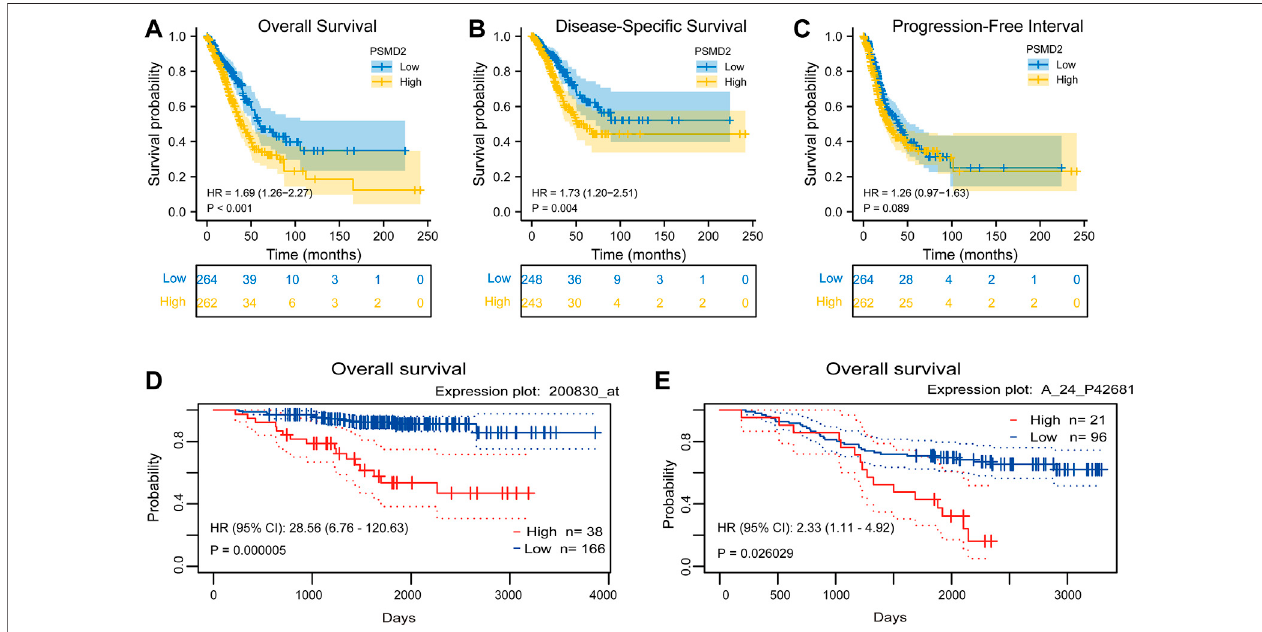
FIGURE 3 | Correlation between PSMD2 expression and prognosis in lung adenocarcinoma. (A) Higher PSMD2 expression had a shorter overall survival. (B) Higher PSMD2 expressionhadashorterdisease-speci fi csurvival. (C) Nosigni fi cantdifferencewasobservedbetween PSMD2 expressionandprogression-freeinterval. (D,E) Two datasets (GSE31210, GSE13213) in PrognoScan suggested that high PSMD2 expression was correlated with poor overall survival in lung adenocarcinoma.